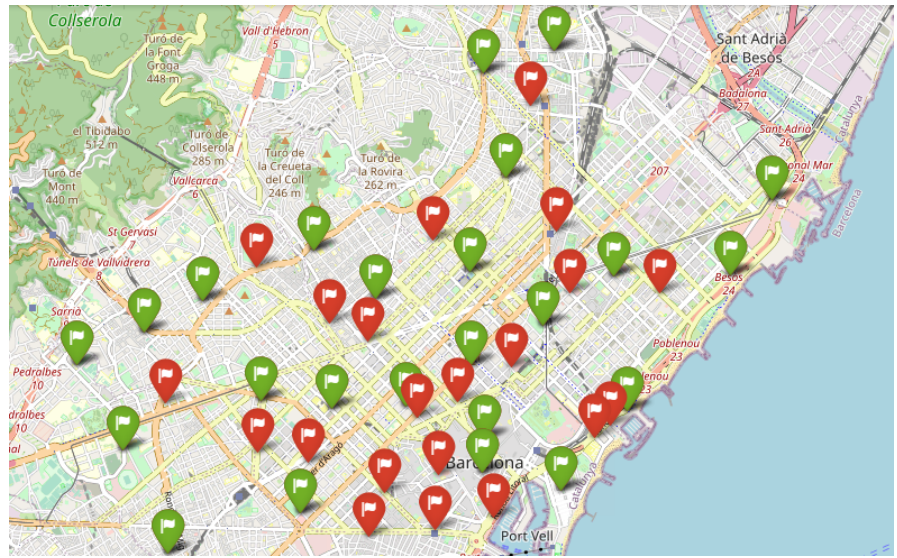
Figure 10. Dense, 24 Selected Facilities.